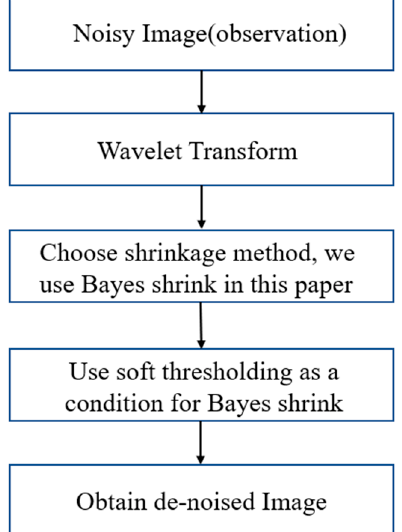
Figure 4. The basic framework of wavelet image de-noising. It shows the process of wavelet de-noising. There are three main steps. (1) Apply wavelet transform to image data and calculate the wavelet coefficients. (2) Find the optimum value for threshold and applying a soft threshold. (3) Calculate the de-noised signal and reconstruct the image.